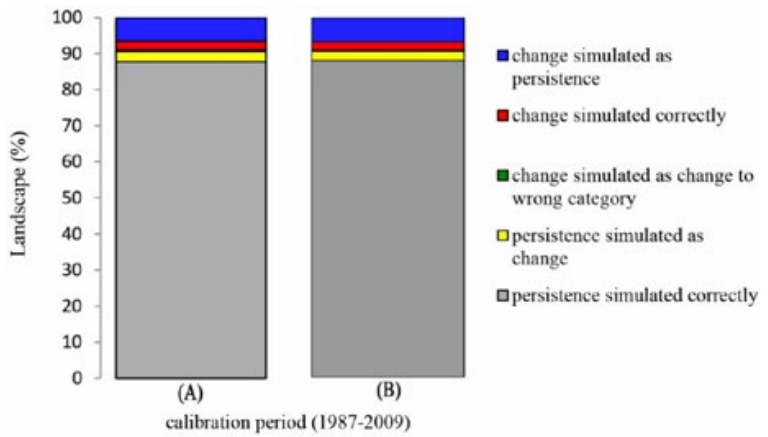
Fig. 6: Agreement and disagreement components in Fuzzy-AHP (A) and MLP (B) simulations